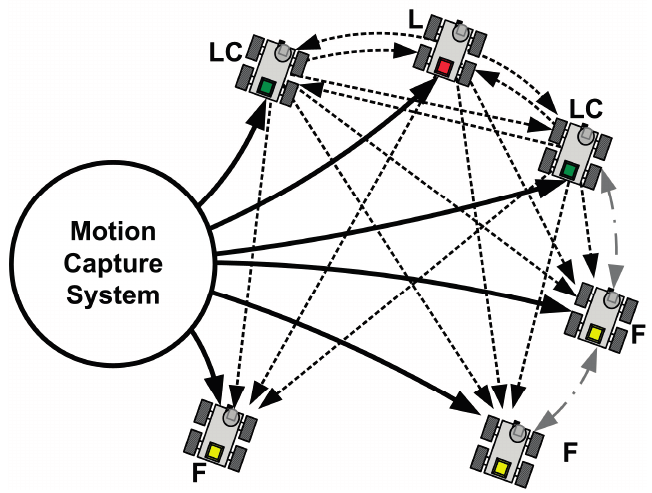
Figure 13. The architecture of the experiment using the motion capture